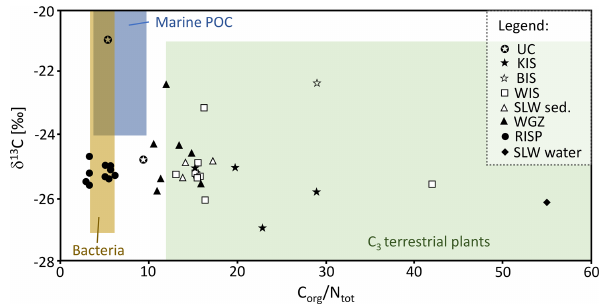
Figure 3. δ 13 C plotted against C org : N tot (atom:atom). Shaded ar- eas taken from Lamb et al. (2006). Although the RISP and WGZ samples are from a sub-ice-shelf cavity, RISP is located mid-ice- shelf, whereas WGZ is located within the grounding zone. The UC samples are sediments melted out from basal ice, as opposed to col- lected below ice or an ocean